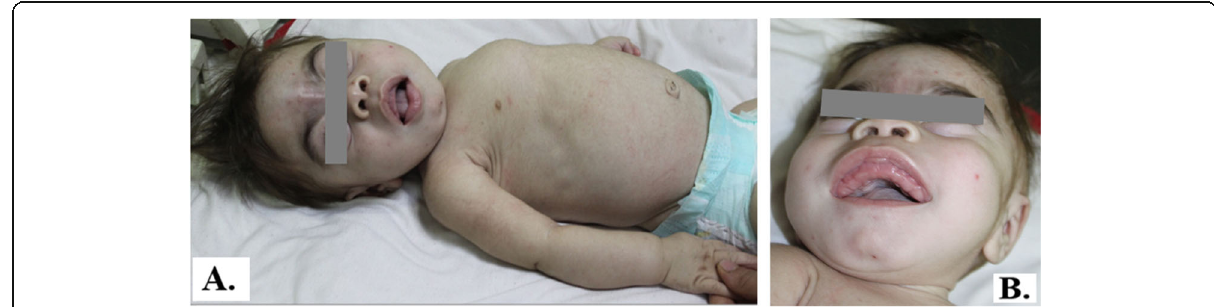
Fig. 3 Patient no. 3 at the age of 1 year. A Clinical features of ML II including coarse facial features, pectus carinatum, and short neck. B Gingival